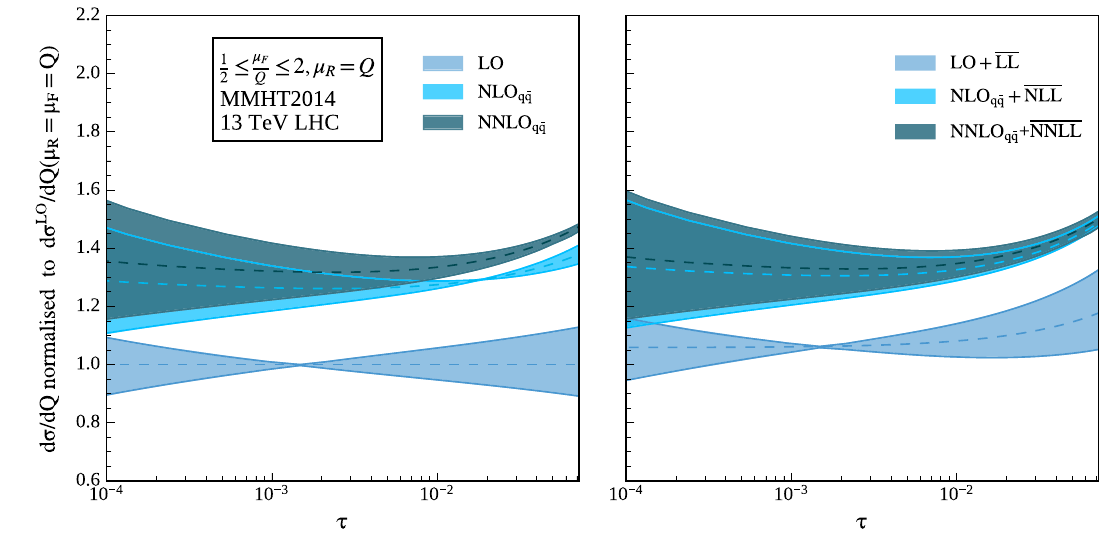
Fig. 6 μ F scale variation of the resummed results against the fixed-order with the scale μ R held fixed at Q for q ¯ q -channel for 13 TeV LHC